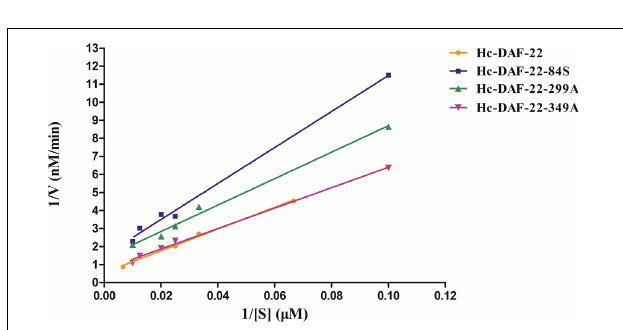
FIGURE 7 | Linewaver–Burke plot of in vitro protease activity assay. Linewaver-Burke plot of each protein was drawn according to the reaction rates (V) and corresponding substrate concentrations ([S]). X axis represents the value of 1/[S]. The Km value was calculated from the Michaelis equation. Detailed values of Vmax and Km were listed in Table 2 .